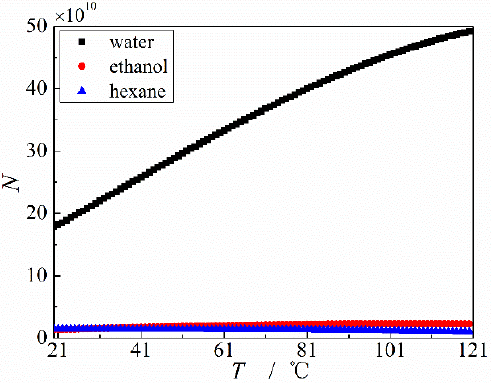
Figure 11. Merit factors of deionized water, anhydrous ethanol, and